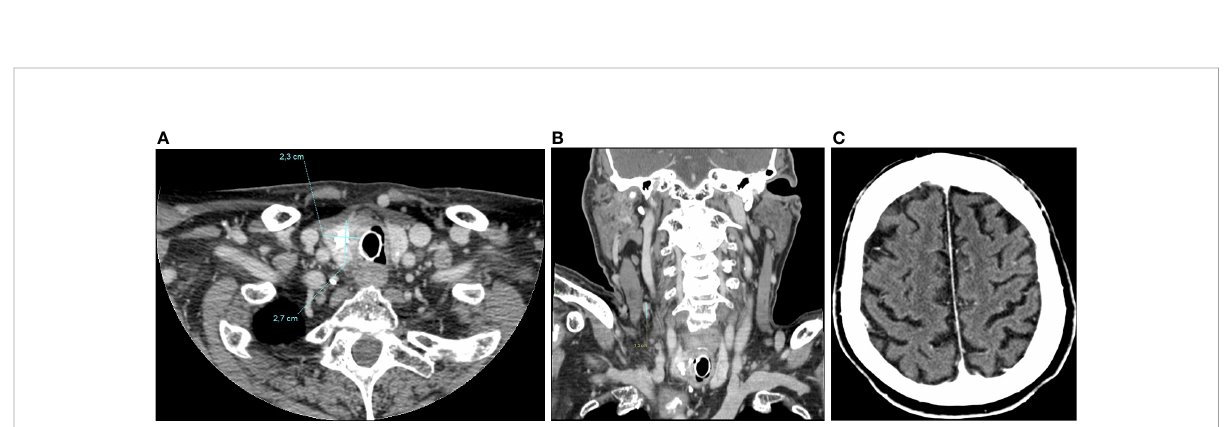
FIGURE 6 CT-scan performed in October 2022, 13 months after the beginning of treatment, showing a further tumor volume reduction of left thyroid lobe (2,3x2,7cm) (A) , of latero-cervical lymphadenopathies (maximum diameter of 1,3 cm) (B) , and a complete radiological response of brain metastases (C)